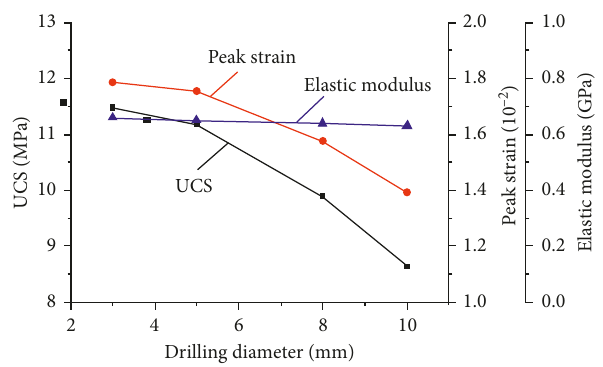
Figure 6: Influence of drilling diameter on the mechanical properties of specimens. UCS: uniaxial compressive strength.